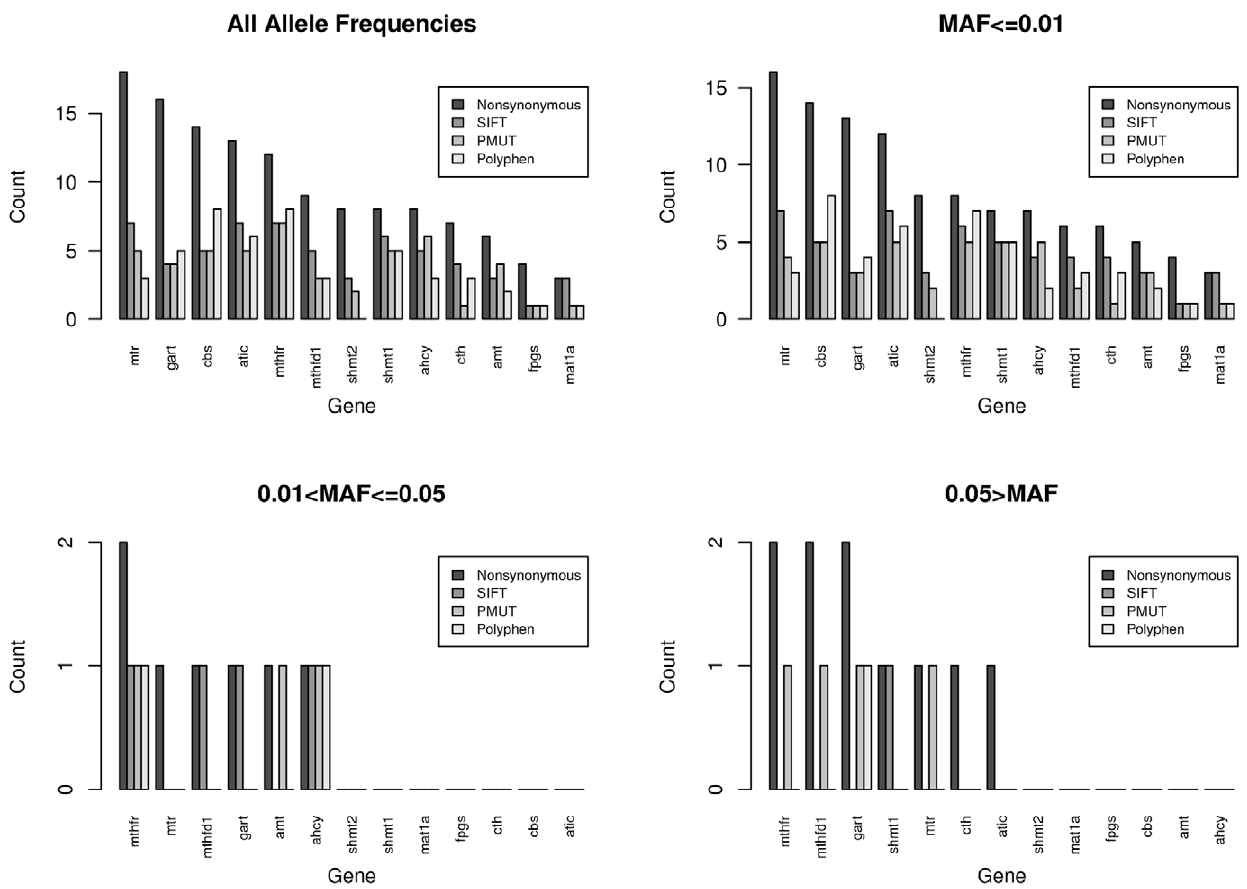
Figure 1. Deleteriousness of variants detected by sequencing one-carbon folate metabolic pathway candidate genes. For each gene, the number of variants from sequencing that are nonsynonymous, and then deemed deleterious by three different methods (SIFT [13], PMUT [14], or PolyPhen [15]) plotted by ranges of the variant’s minor allele frequency. The SIFT designations are generally used here for our simulation studies (except those with common variants, where we used PMUT designations to have more genes with deleterious mutations for simulation purposes).